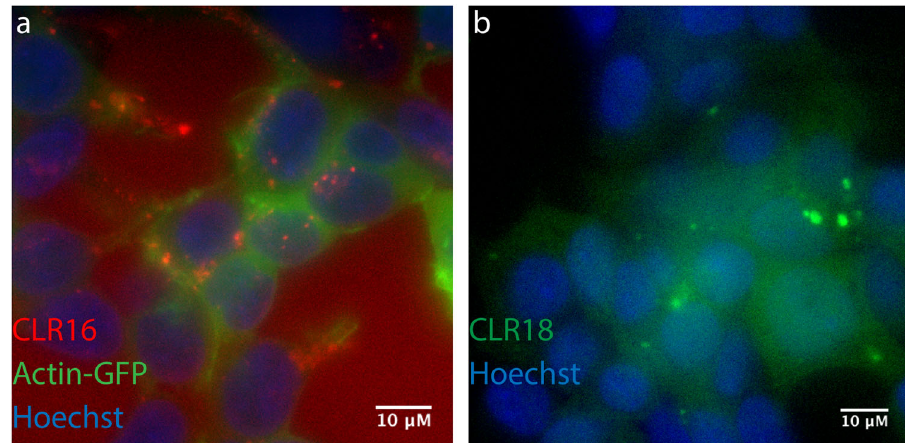
Fig. 2 MTs are internalized in SH-SY5Y cells and concentrate in puncta. SH-SY5Y cells were incubated with fl uorescent MTs for 24 h and visualized by fl uorescence microscopy. a Cells were transiently transfected with GFP-actin (green), incubated with 5 µ M CLR16 (red), and nuclei were stained with Hoechst (blue). b Cells were incubated with 10 µ M CLR18 (green) and nuclei were stained with Hoechst